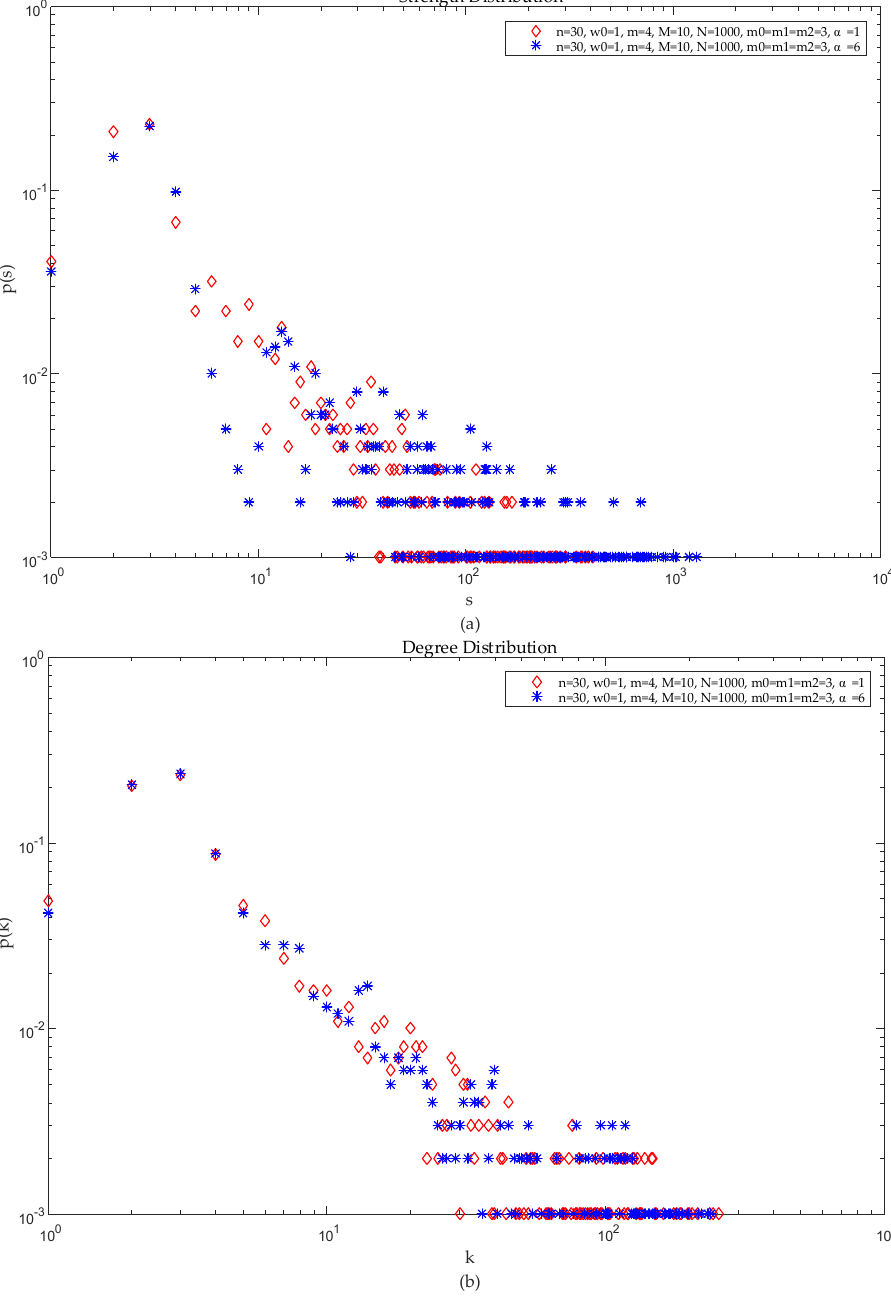
Figure 8. Analysis of the influence of extra traffic load α on network structure performance: ( a ) Distribution of node strength. ( b ) Distribution of node